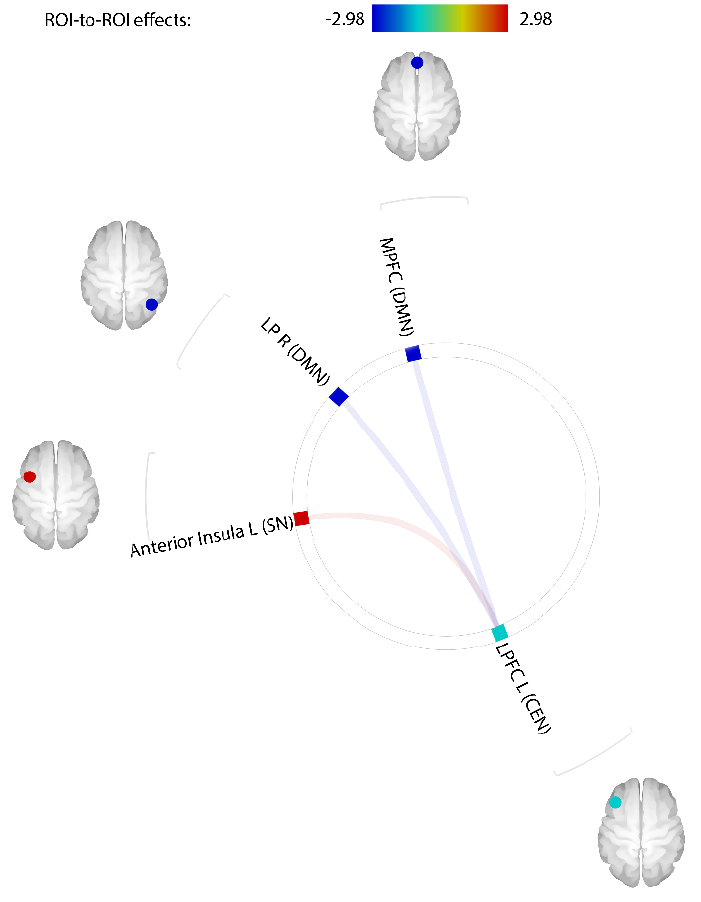
Figure 1. Comparisons of rsFC values between PIU group and control group. rsFCs of the PIU group, in comparison to control group, were higher between left LPFC and left AI (T (53) = 2.83, q = 0.044), but lower between left LPFC and MPFC (T (53) = − 2.93, q = 0.044) and between left LPFC and right LP (T (53) = − 2.98, q = 0.044). rsFCs, resting-state Functional Connectivity; PIU, Problematic